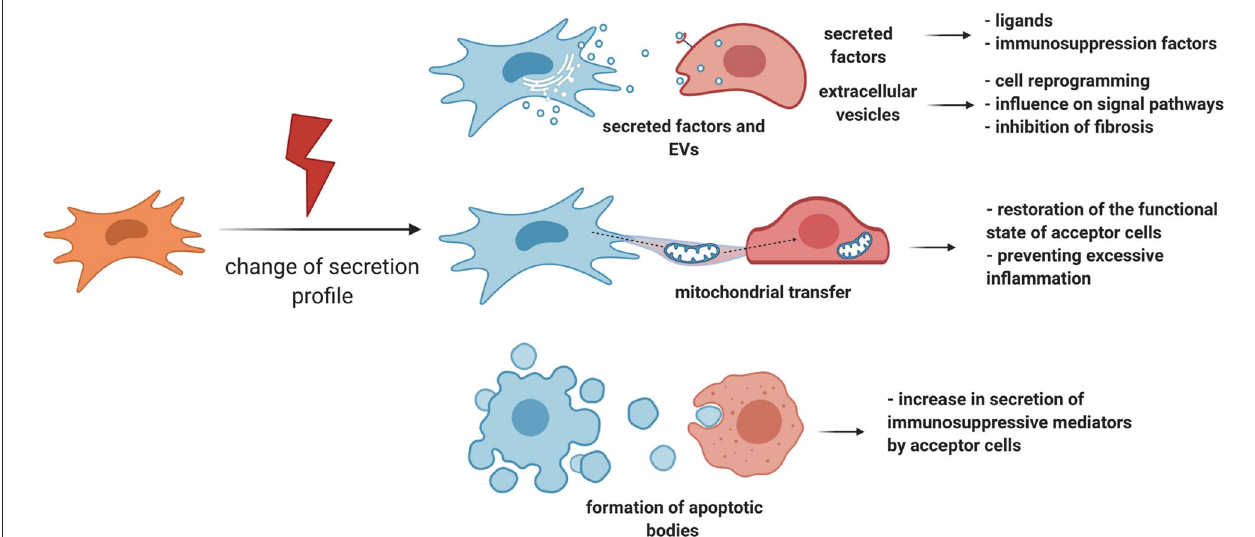
FIGURE 3 | MSC can regulate tissue regeneration by secretion of paracrine factors, extracellular vesicles, and organelle transfer. MSCs have the ability to respond to damage by changing the number and panel of secreted factors. Particularly, MSCs can exhibit a paracrine response to stem cell demand signals during damage and contribute to tissue regeneration. Another important response of MSCs to damage is the activation of an immunosuppression program. In addition to the secretion of individual paracrine factors, MSCs can secrete EV or transfer individual organelles, such as mitochondria, through vesicular or tunnel nanotube transport. MSCs, mesenchymal stromal cells; EV, extracellular